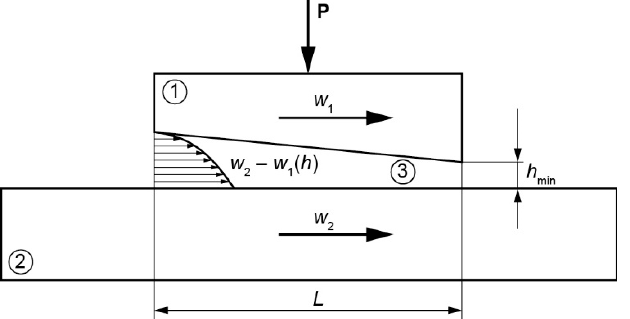
Figure 3. Tribological model of slide bearing. The converging gap and the distribution of fluid speed in the gap: 1, 2—elements forming a node moving at speed w 1 and w 2 : w 2 > w 1 ; 3—separating fluid;